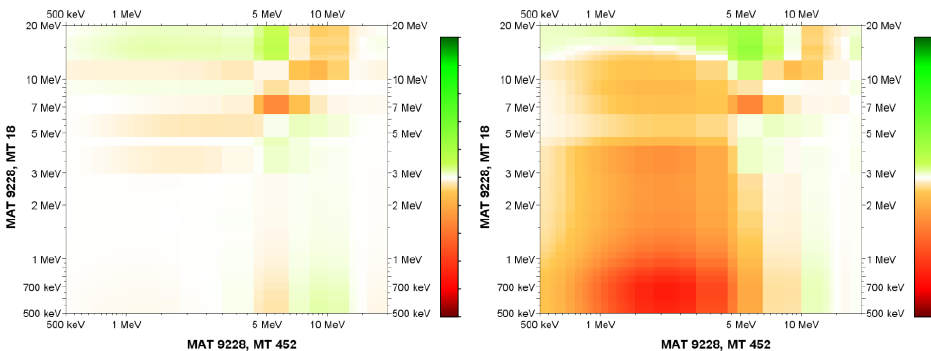
Fig. 2. Results for BMC adjustment, fission (left) and total inelastic (right) cross-sections. The figures show the predicted posterior values using experimental adjustments with Godiva(HMF1), LLNL- pulsed sphere or both benchmarks together divided by prior cross-sections.